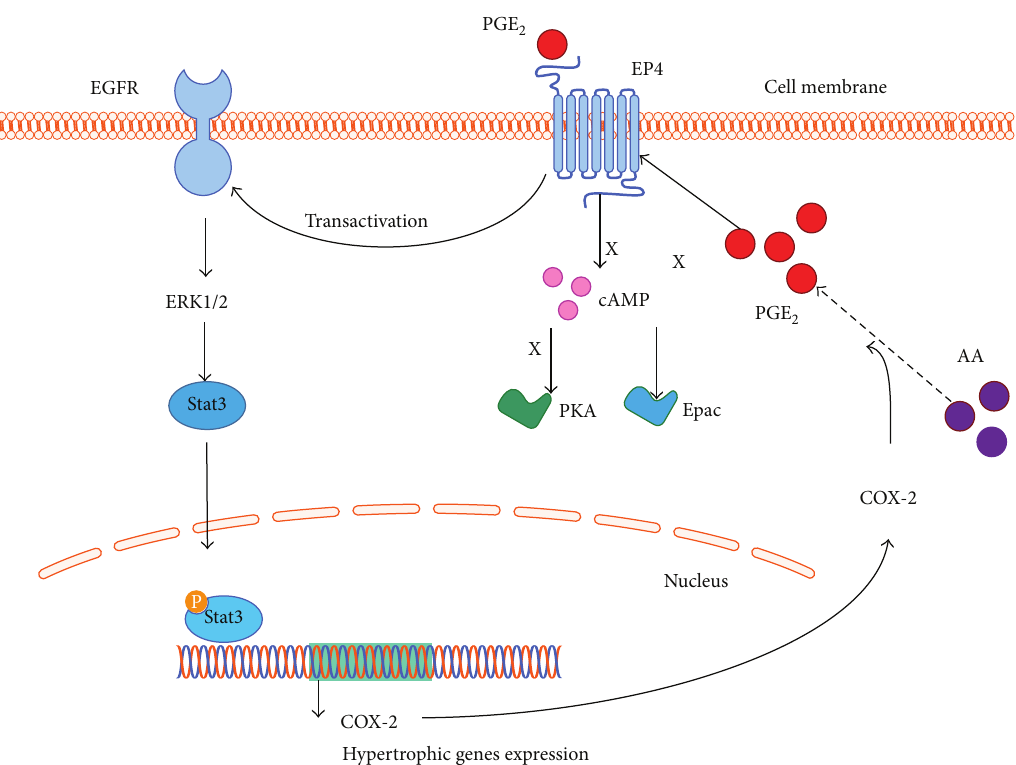
Figure 3: Simplified scheme of the EP4 signaling in PGE 2 -mediated hypertrophic actions. In response to PGE 2 , activation of EP4 transactivates epidermal growth factor receptors (EGFR), which can result in the activation of extracellular signal-regulated kinases (ERK1/2). ERK1/2 in turn activated signal transducer and activator of transcription 3 (Stat3) pathway. Once Stat3 signaling is activated in the nucleus, the hypertrophic genes will be expressed to mediate the protein synthesis. In addition, cyclooxygenase-2 (COX-2) expression is also stimulated by Stat3 signaling, which will further metabolize the formation of PGE 2 from arachidonic acid (AA) and trigger the greater activation of Stat3 signaling in a positive feedback loop. Cyclic adenosine monophosphate (cAMP)/protein kinase A (PKA) or cAMP/exchange protein directly activated by cAMP (Epac) pathways are not involved in the PGE 2 -EP4-mediated hypertrophic actions in ventricular myocytes.